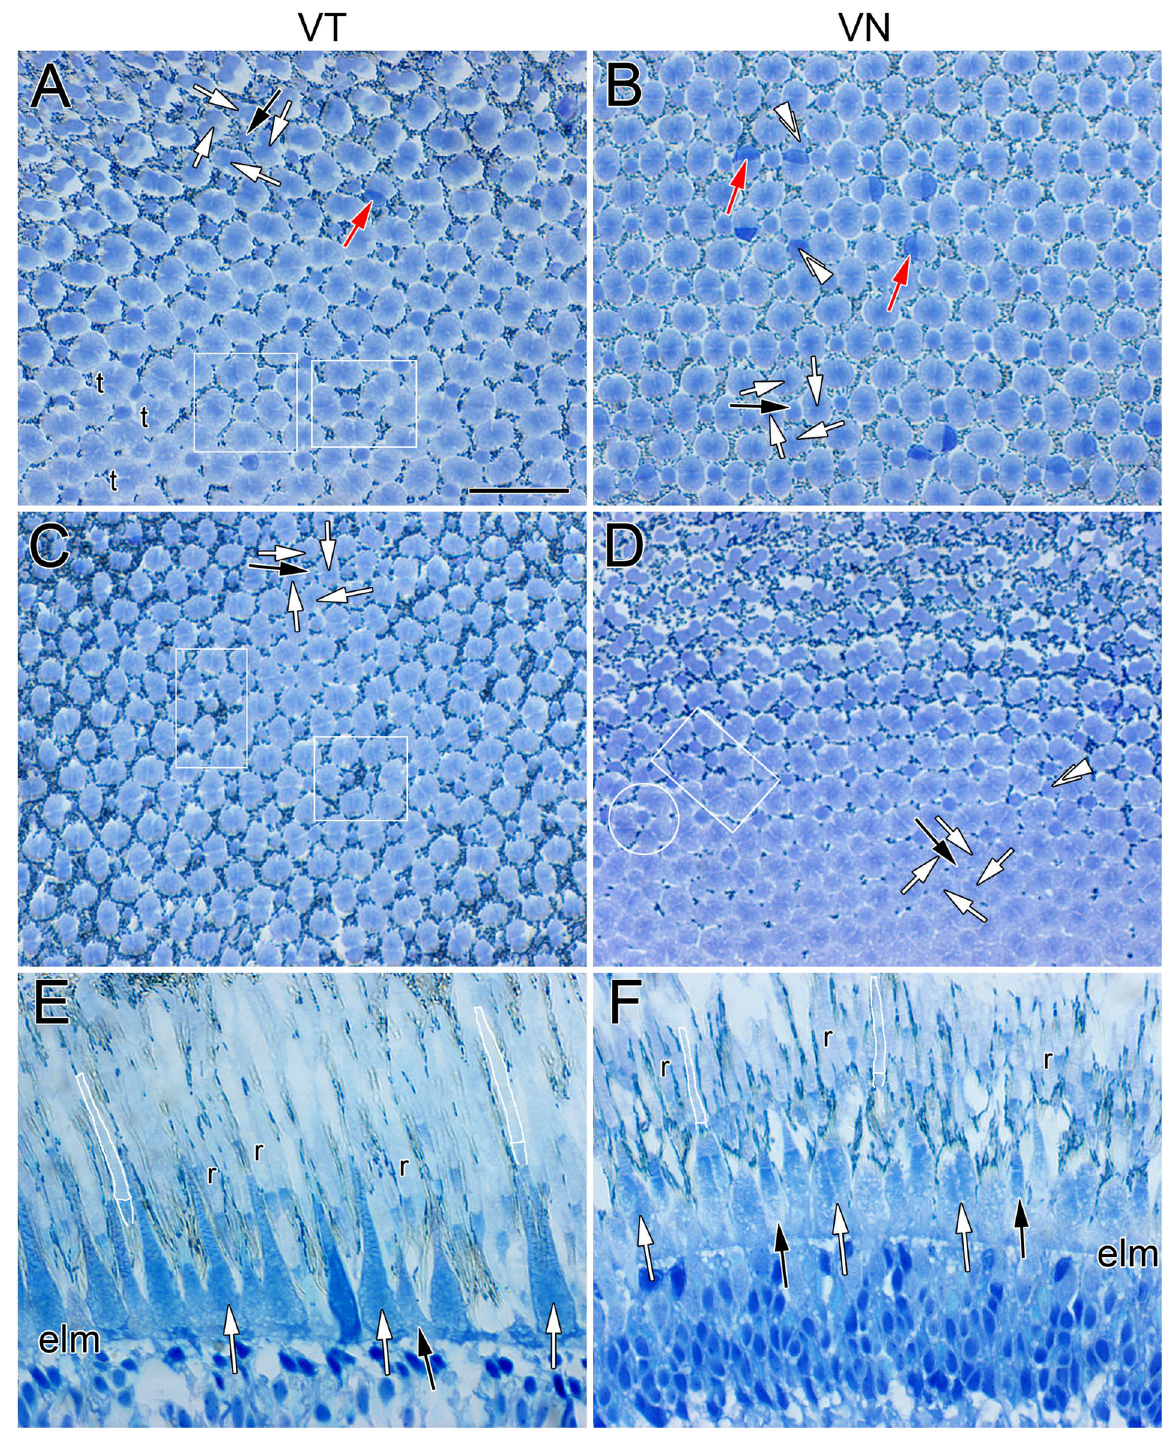
Figure 5. Micrographs of EPON sections showing cone distributions from the ventral retina at 878 ATU. ( A – D ) Tangential sections of central retina from the ventrotemporal ( A ) and ventronasal ( B ) quadrants and corresponding sections from the ventrotemporal ( C ) and ventronasal ( D ) periphery. White rectangles in ( A , C , D ) show cone arrangements that deviate from the square mosaic and the white circle in ( D ) illustrates a single cone surrounded by three double cones. The double white arrowheads in ( B , D ) point to single corner cones, which face the partitions of adjacent double cones. ( E , F ) Radial sections from the central regions of the ventrotemporal ( E ) and ventronasal ( F ) quadrants; white contours depict rods Abbreviations: r, rod; elm, external limiting membrane. Other symbols and abbreviations as per Fig. 2. Scale bar in ( A ) equals 10 µm and holds for ( B – F